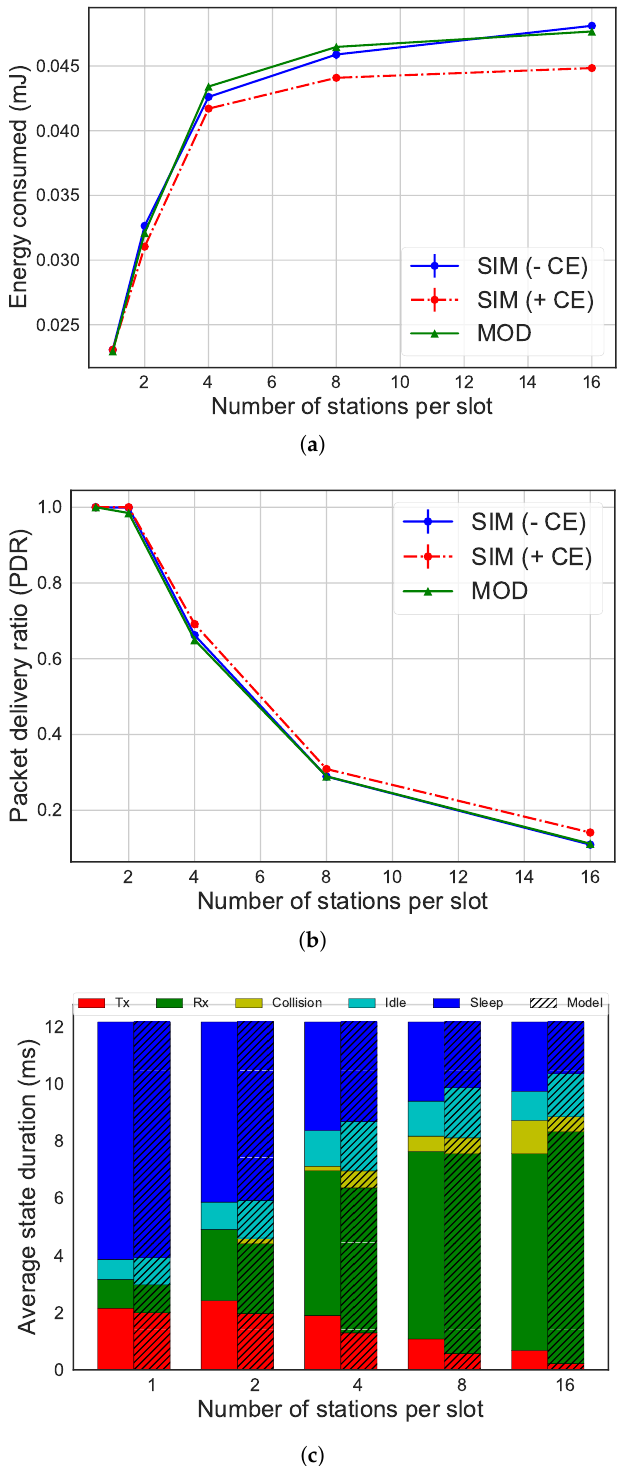
Figure 5. Comparison of results between simulation without CE (SIM − CE) and with CE (SIM + CE) and analytical MOD for 600 kbps, 64 bytes as payload size and 14336 µ s as slot duration. ( a ) average energy consumption per STA; ( b ) PDR; ( c ) radio state duration per